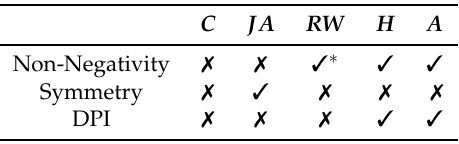
Table 2. Properties of different MI deffinitions ( (cid:51) stands for satisfied, (cid:55) for not satisfied, and (cid:51) ∗ for satisfied for α ≥